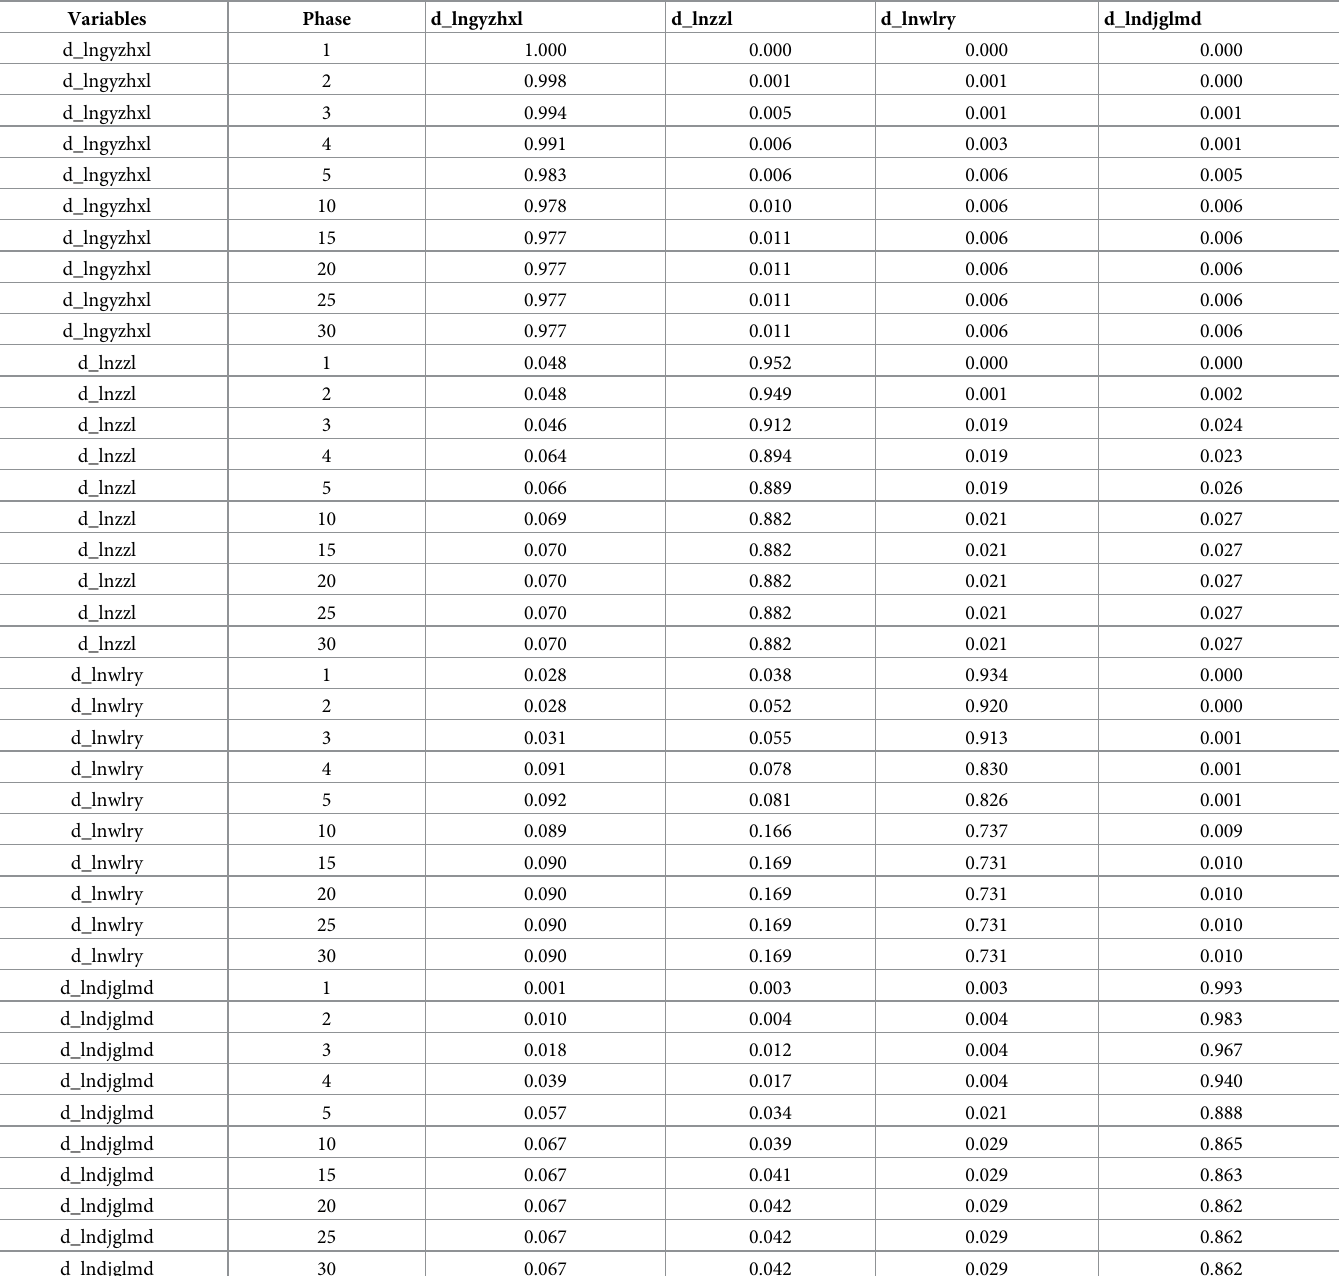
Table 10. Variance decomposition of logistics industry and the comprehensive technical efficiency of manufacturing industry.